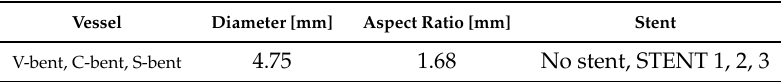
Table 2. Summary of the geometrical cases analyzed.